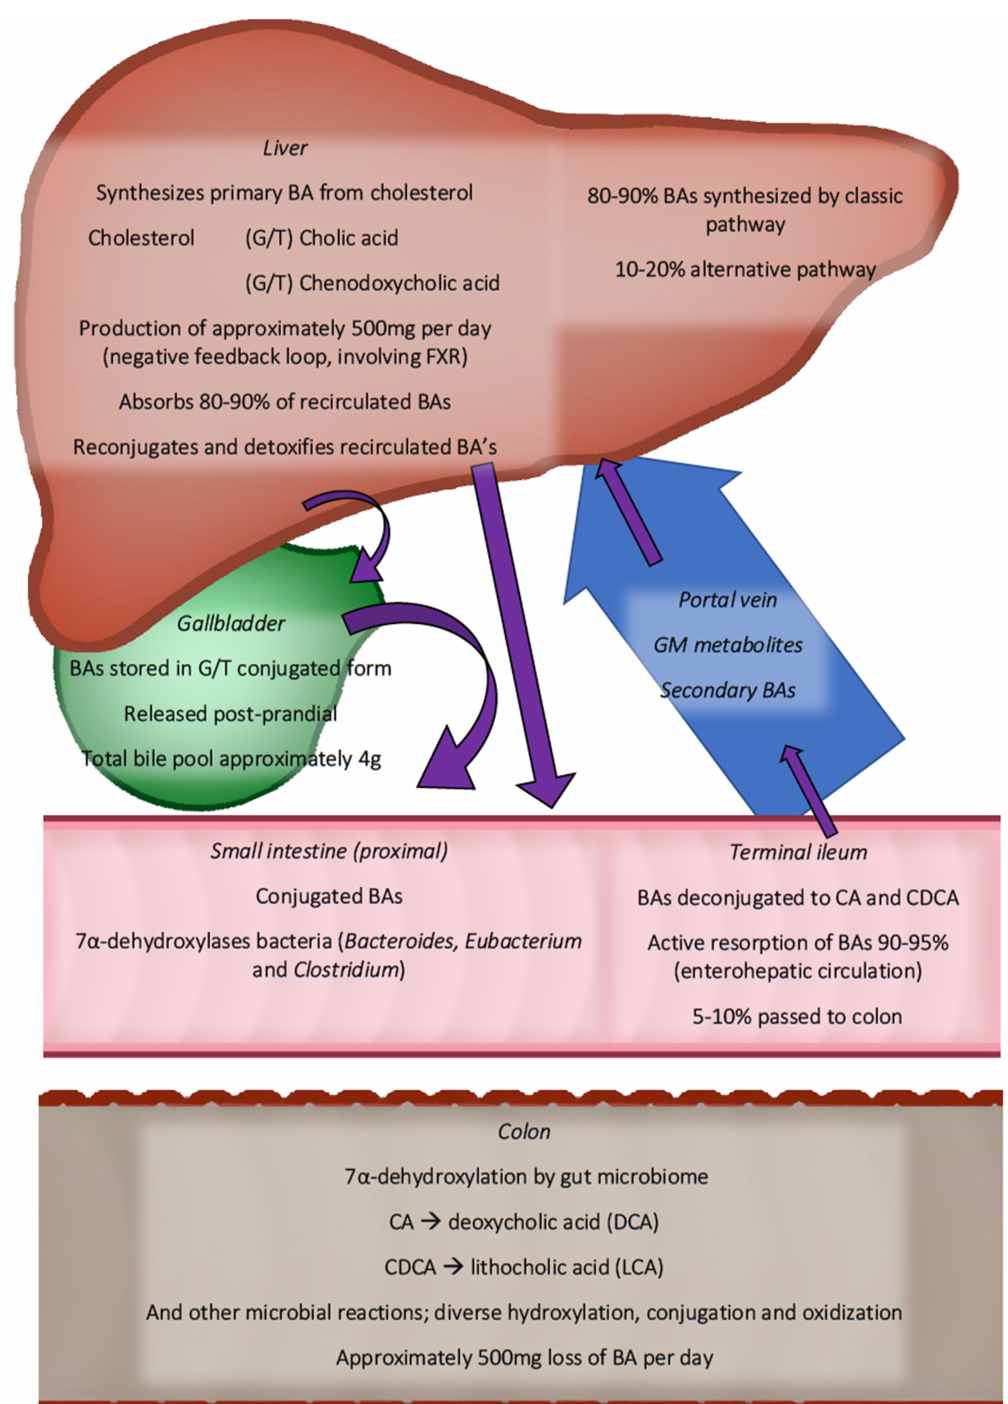
Figure 2. Overview of enterohepatic circulation gut microbiota in bile acid in human metabolism. Purple arrows show the route of bile acids collectively. Only the most abundant bile acid species are shown. BAs are synthesised in the liver (500 mg daily) and are transported through the bile ducts to the small intestine. Starting in the distal ileum, microbiota are found, increasing in density towards the distal colon. More than 90% of bile acids are reabsorbed in the distal ileum. The remainder continues, where they are transformed into secondary bile acids. In total, 500 mg of BAs are lost daily with the stool. BA—bile acid, CA—cholic acid, CDCA—chenodeoxycholic acid, FXR—farnesoid ‐ X ‐ receptor, and G/T—glycine or Taurine conjugated.